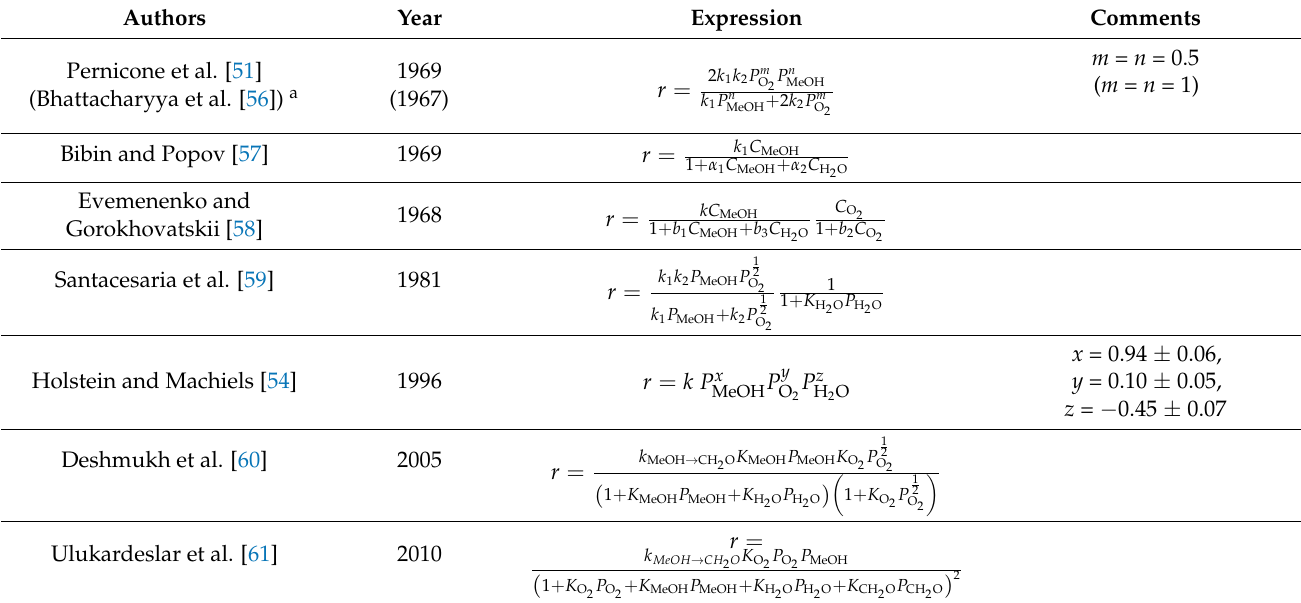
Table 1. Proposed rate expressions in literature for the oxidation of MeOH to